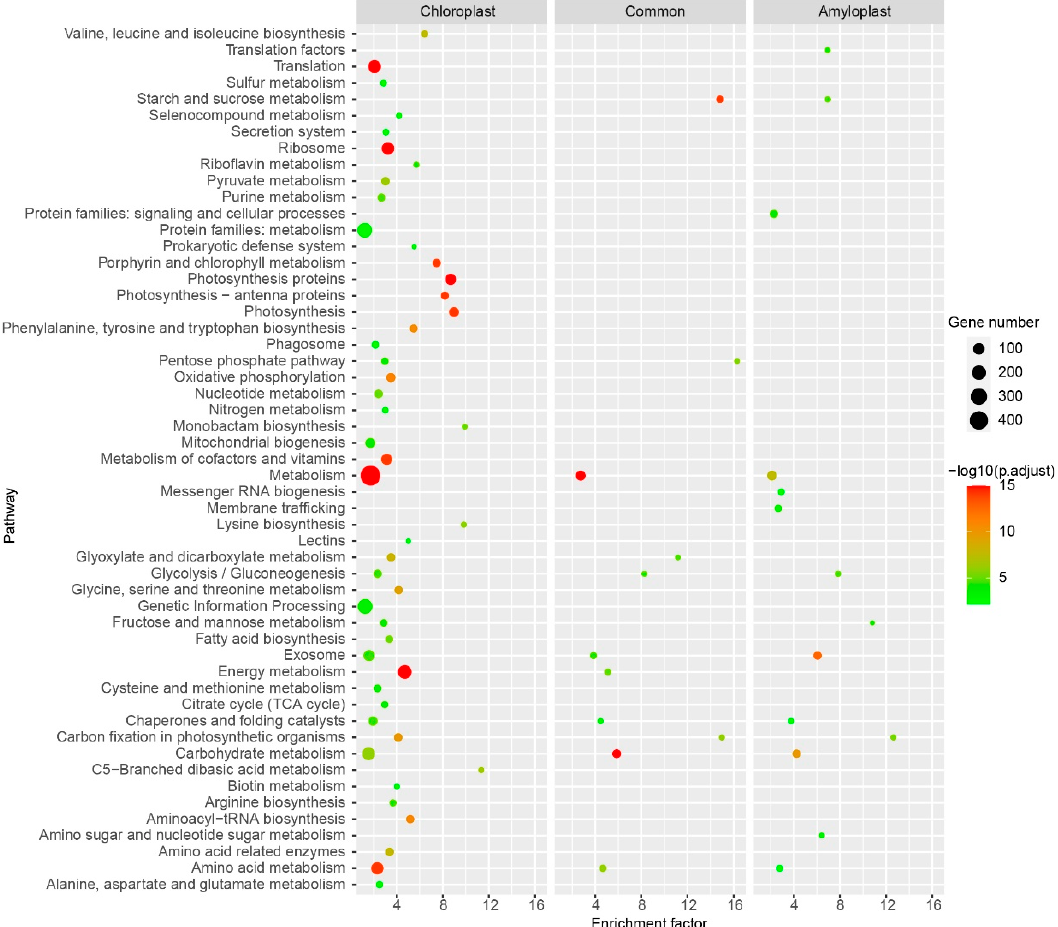
Figure 6. KEGG pathway analyses for chloroplast-unique protein set, amyloplast-unique protein set, and common protein set in chloroplasts and amyloplasts, respectively. The detailed information for these KEGG pathway analyses is given in Supplementary Table S6.